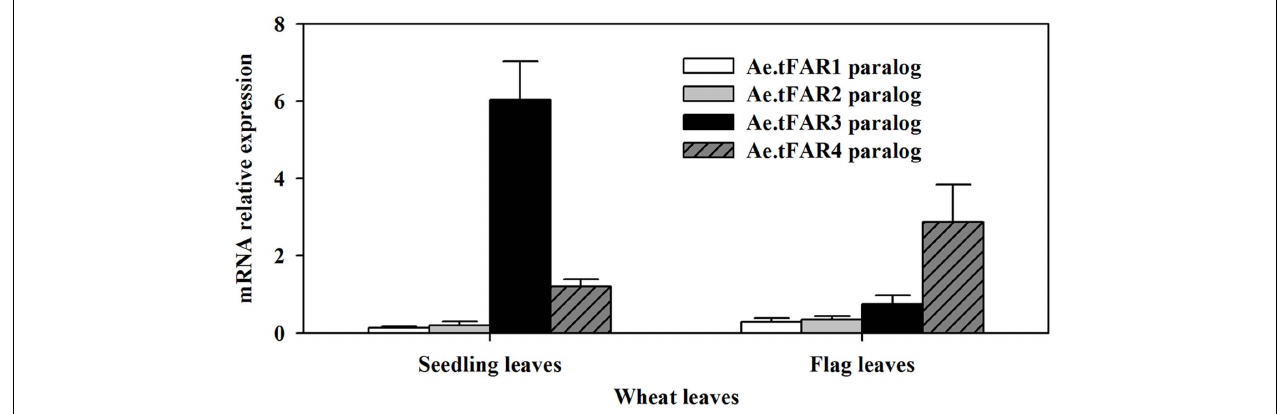
FIGURE 6 | Expression analyses of Ae.tFAR paralogous genes in hexaploid wheat. The relative expression levels of Ae.tFAR paralogous genes were determined in seedling leaves and flag leaves of wheat (cv. Chinese Spring, CS) by qRT-PCR analysis. Each value is the mean of three independent parallel experiments. Error bars represent the